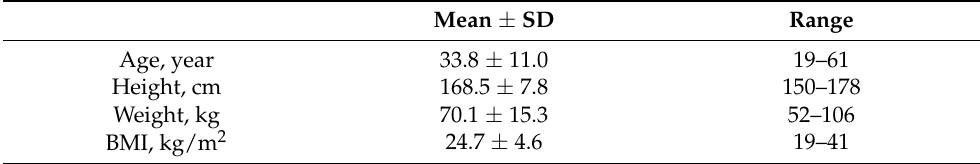
Table 1. Subject characteristics ( n =